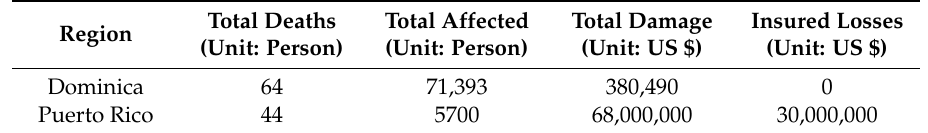
Table 1. Detail quantification of the damage caused by Hurricane Maria. Total Deaths Total Affected Total Damage Insured Losses Region (Unit: Person) (Unit: Person) (Unit: US $) (Unit: US $) Dominica 64 71,393 380,490